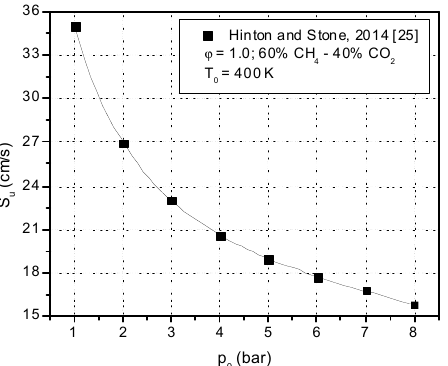
Figure 9. Initial pressure influence on experimental laminar burning velocity for stoichiometric equivalence ratio and 400 K.